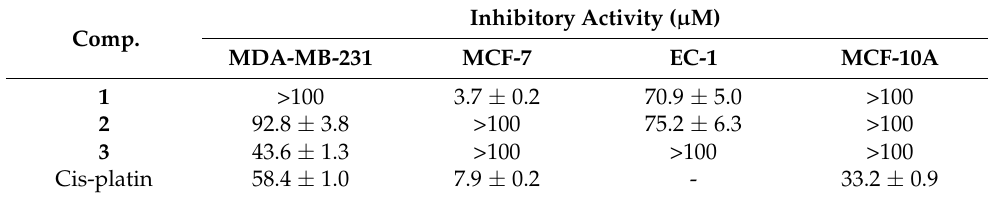
Table 1. Inhibitory activity (IC 50 / µ M) of the Ru(II) complexes against selected cell lines. Comp.